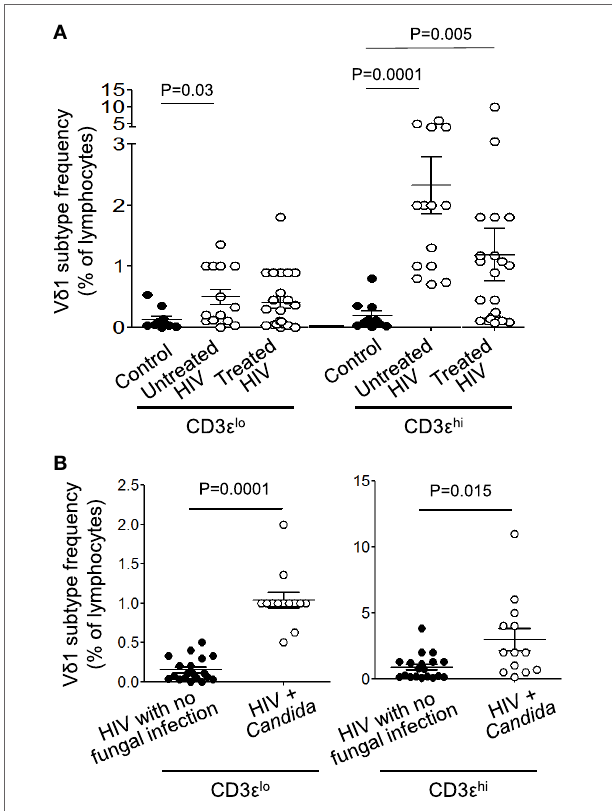
FigUre 4 | Both CD3 ε lo and CD3 ε hi V δ 1 T cells are expanded in untreated patients with human immunodeficiency virus (HIV) infection and especially in patients with Candida co-infection. Peripheral blood mononuclear cells were prepared from blood samples of 14 patients with untreated HIV infection, 22 patients receiving antiretroviral therapy and 23 healthy donors, stained with monoclonal antibodies specific for CD3 ε and V δ 1 and analyzed by flow cytometry. (a) Scatter plots showing the frequencies of circulating CD3 ε lo and CD3 ε hi V δ 1 T cells in untreated and treated patients with HIV infection and healthy control subjects. (B) Scatter plots showing the frequencies of circulating CD3 ε lo and CD3 ε hi V δ 1 T cells in patients with HIV divided according to the absence ( n = 19) or presence ( n = 13) of Candida albicans co-infection. Groups were compared using the Mann–Whitney U